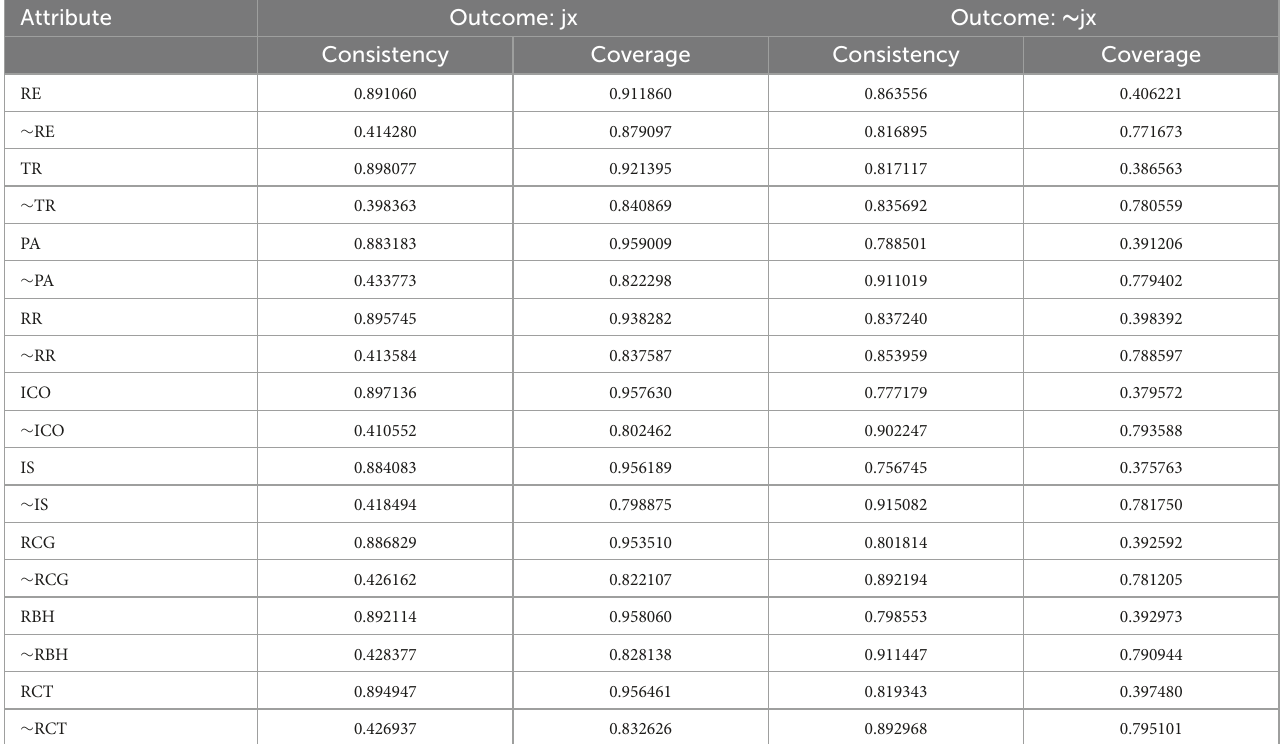
TABLE 2 Analysis of the necessary conditions for high/non-high enterprise performance.